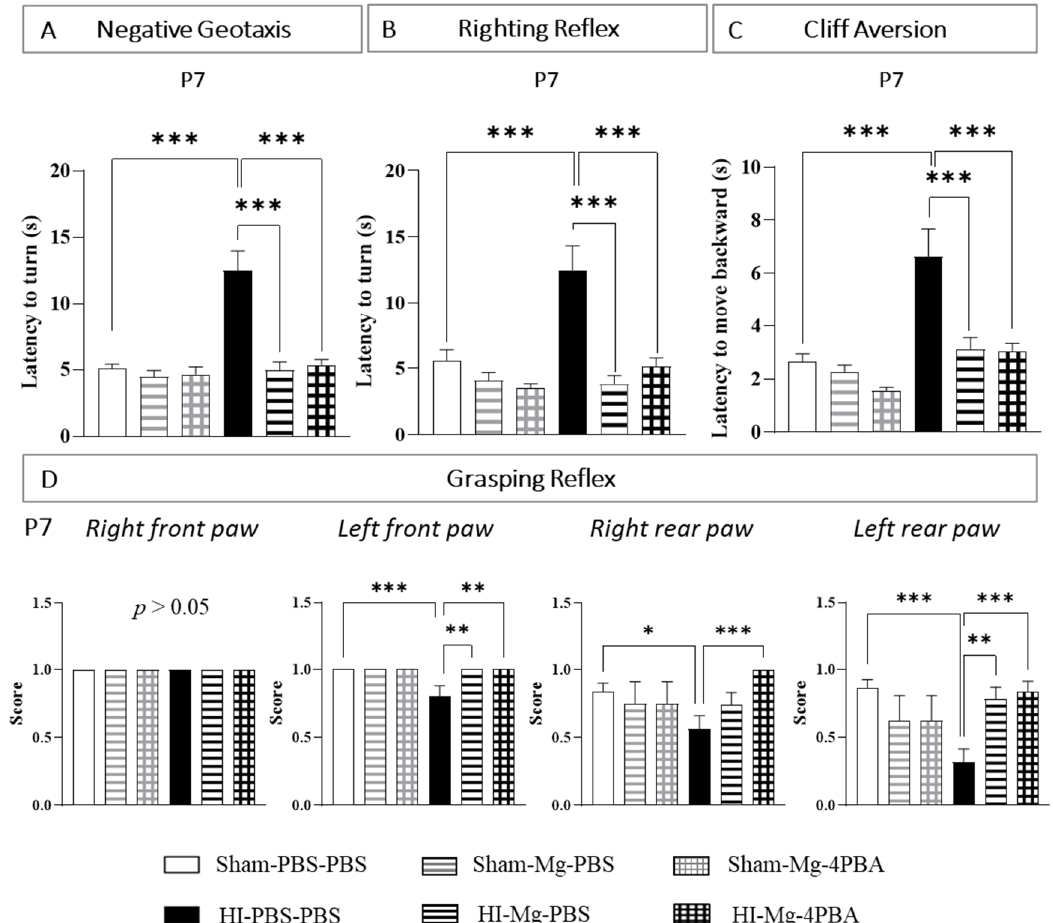
Figure 1. Effects of the neonatal HI, MgSO 4 or of the MgSO 4 /4-PBA association on pups’ perfor- mances in the negative geotaxis ( A ), righting reflex ( B ), cliff aversion ( C ) and grasping reflex ( D ) tests at P7. Data are expressed as the latency (s) to turn ( A , B ) and to move backward ( C ), or as the presence or absence of the grasping reflex for each paw (score: 0 when reflex is absent, 1 when reflex is observed). ( D ) Sexes are pooled. Data are expressed as M ± S.E.M. n = 10–30 pups/group. Two-